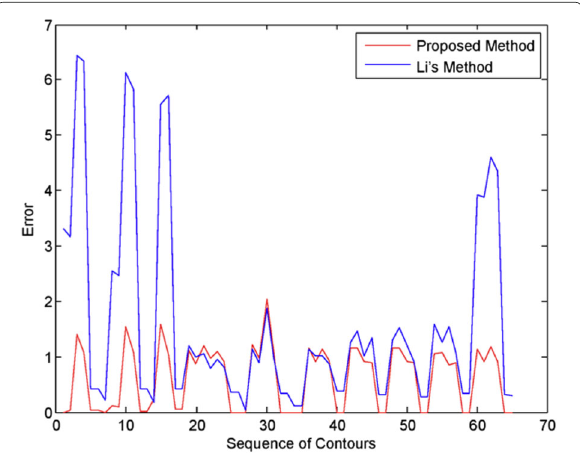
Fig. 8 Comparison of errors in different